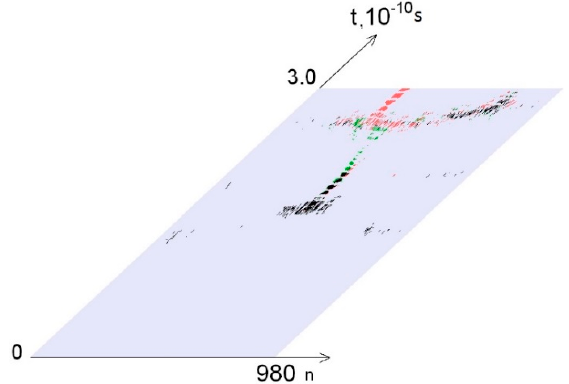
Figure 2. Dynamics of open states occurrence for the gene encoding interferon alpha 17, E H cr = 0.31 × 10 − 22 N · m. Note: green dots show open states dynamics, when deuterium was placed in i min (365 base pair, Table 2), red dots show open states dynamics, when deuterium was placed in i max (711 base pair, Table 2) and black dots represent coincidence values for i min and i max .